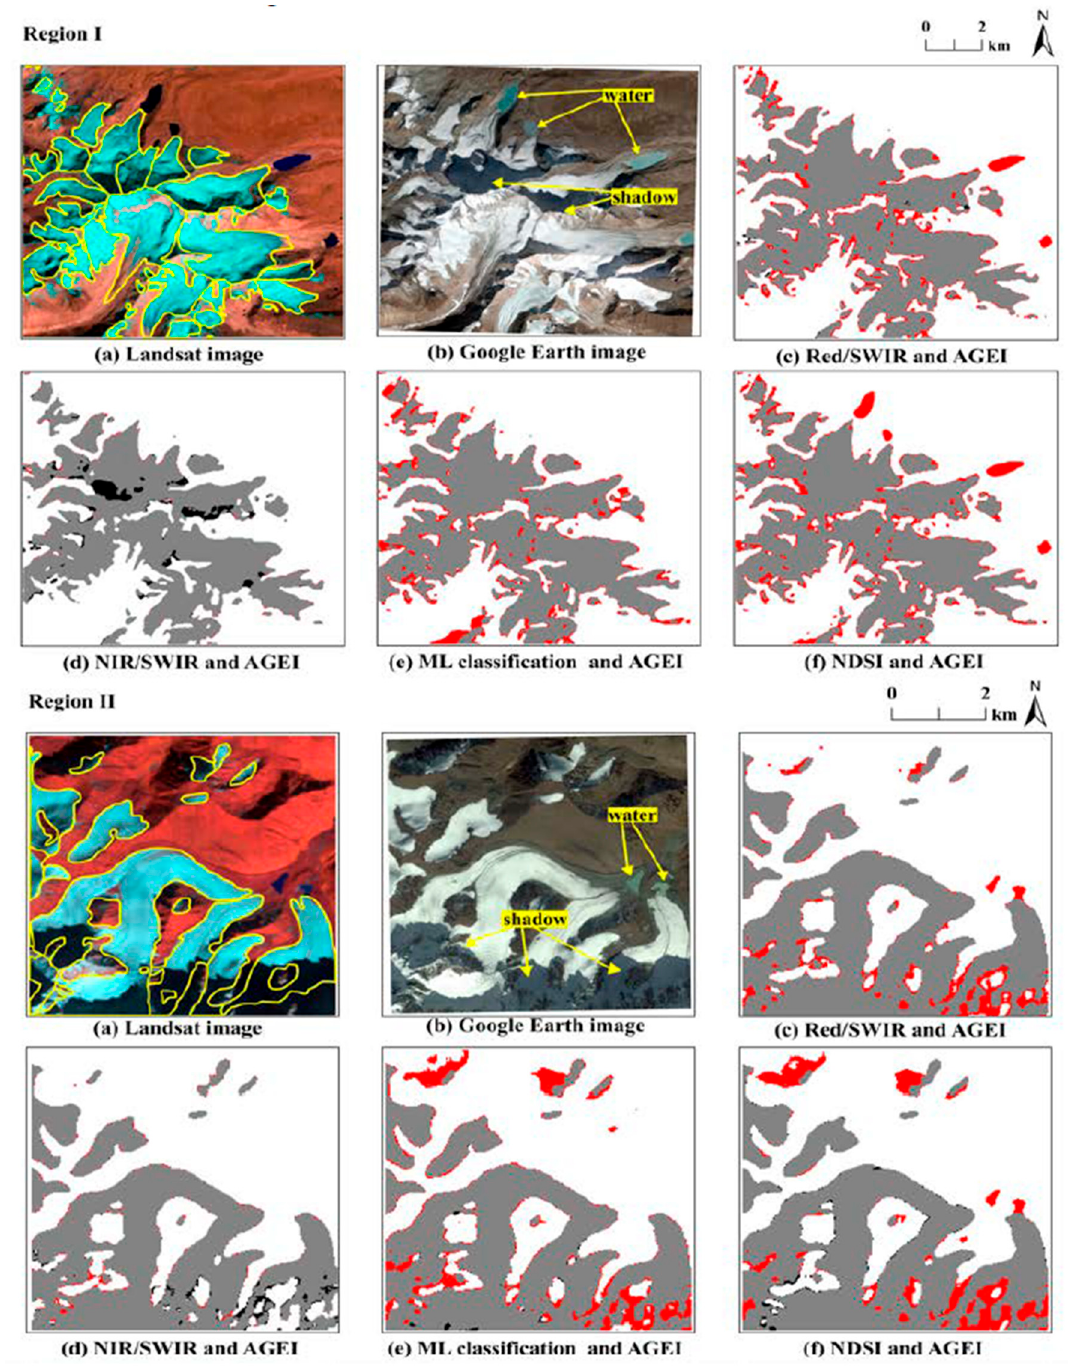
Figure 5. Glacier masks comparing two methods. Areas in grey were identified by both methods as being a glacier, red areas only by the first method, and black areas only by the second method in Region I and II. ( a ) Superimposed map of manual glacier delineations and Landsat images of test sites; and ( b ) high resolution Google Earth images of test sites. The compared methods are: ( c ) Red / SWIR and AGEI; ( d ) NIR / SWIR and AGEI; ( e ) supervised ML classification and AGEI; ( f ) NDSI and AGEI.